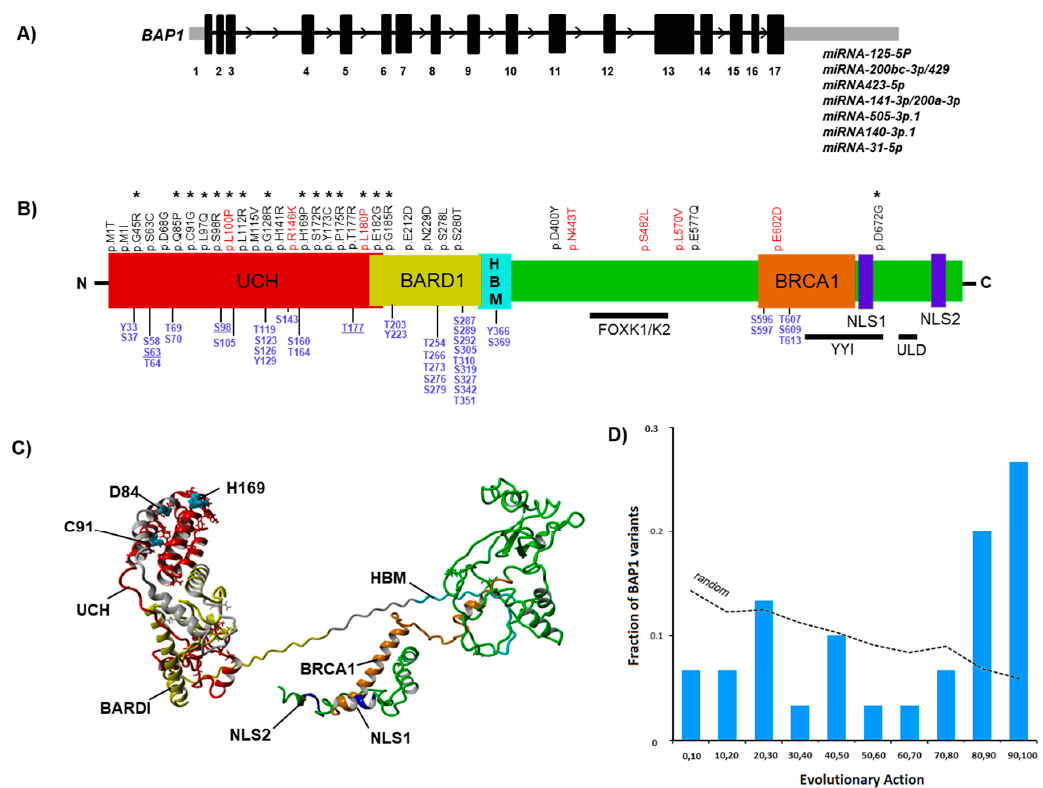
Figure 1. BAP1 mutational landscape and determinants of the protein structure. ( A ) Gene structure and miRNAs embedded in the 5´UTR region of BAP1 . ( B ) Schematic structure of BAP1 domains with precise locations of UM-associated missense mutations (Somatic: Black; Germline: Red) and the phosphorylation residues (blue). Mutations with high evolutionary action (EA) score are marked by an asterisk. ( C ) The BAP1 structural model is shown in ribbon format with individual domains and regions of interest colored differently and labelled. The reported mutated residues are depicted as stick models, while the active site residues are depicted in ball models. ( D ) Plot showing EA score of the BAP1 variants (bars) and the fraction of the 4772 random missense BAP1 variants (dotted line).